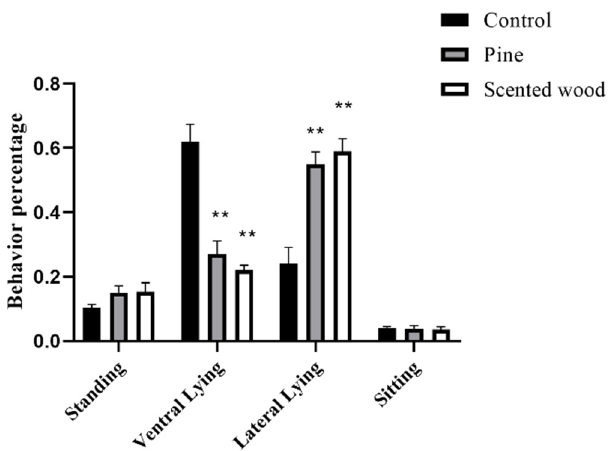
Figure 3. The effect of enrichment items on the posture behaviors of sows. ** p < 0.01 in enrichment item groups vs. control group. The data are expressed as mean ± SEM (n = 10).